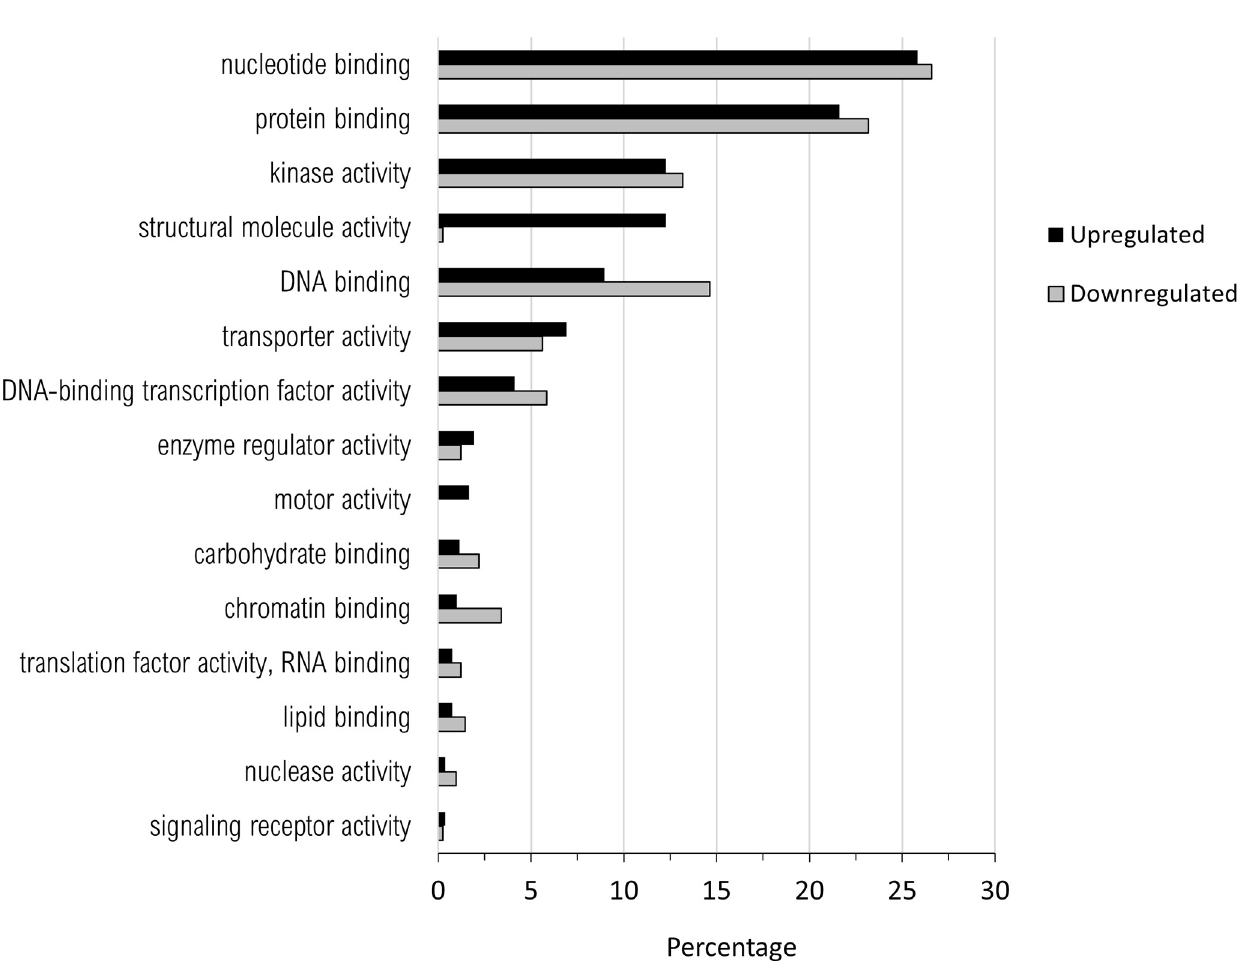
Fig 6. Percentage of upregulated (total number = 782) and downregulated (total number = 410) when nickel resistant Populus tremuloides genotypes were compared to nickel susceptible genotypes. Transcripts were assigned gene ontology and grouped by Molecular Function using BLAST2GO (Omics